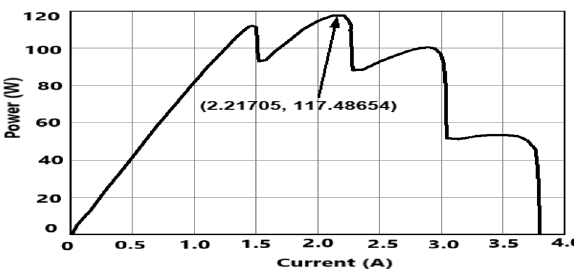
Figure 7. The P–I curve under partial shading condition (PSC).